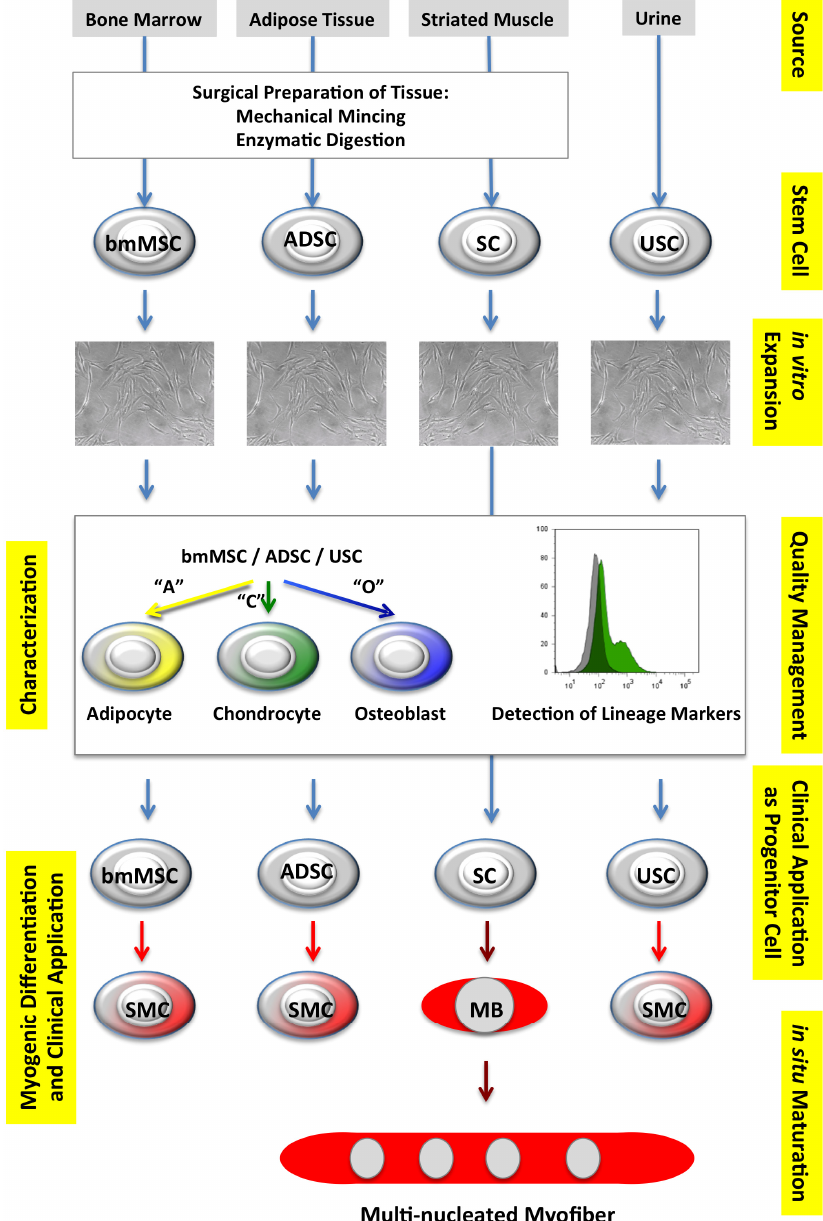
Figure 1. Selected progenitor cells, sources, and myogenic differentiation. Suitable progenitor cells, sometimes also referred to as “stem” cells, can be isolated from different sources, such as bone marrow, adipose tissue, striated muscle, or urine, to generate bone marrow-derived mesenchymal stromal cells (bmMSC), adipose-derived stem cells (ADSC), satellite cells (SC), or urine-derived stem cells (USC). After a primary expansion the quality of bmMSC, ADSC, and USC is explored by adipogenic (“A”), chondrogenic (“C”) and osteogenic (“O”) differentiation of the stem cells, and by detection of the expression of the inclusion/exclusion cell surface antigens [34,37,55]. For SC expression of lineage-specific marker antigens is investigated (not shown). The bmMSC, ADSC, SC, or USC are then either applied as progenitor cells, or incubated in differentiation media to generate smooth muscle cells (SMC), for example, from bmMSC, ADSC or USC, or myoblasts (MB) and multinucleated myofibres from